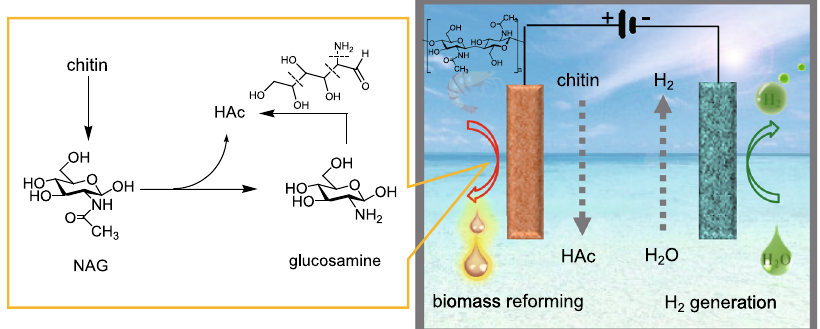
Fig. 1 Hybrid electrolysis for raw biomass reforming and hydrogen evolution. Abundant biopolymer chitin exists in exoskeleton of insects and crustaceans. Electrochemical reforming of chitin selectively to acetic acid (HAc). Left panel: possible main reaction pathways. Right panel: schematic con fi guration of the hybrid